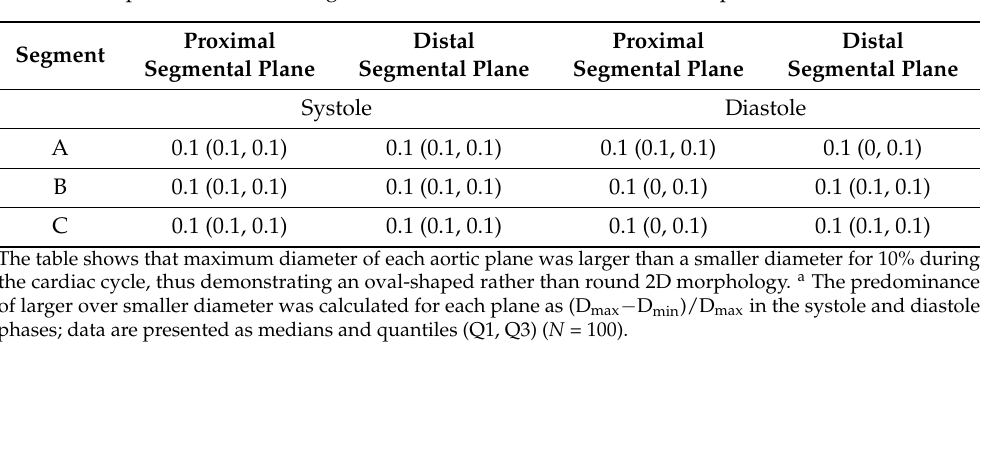
Table 3. The predominance of larger over smaller diameters of the aortic planes a